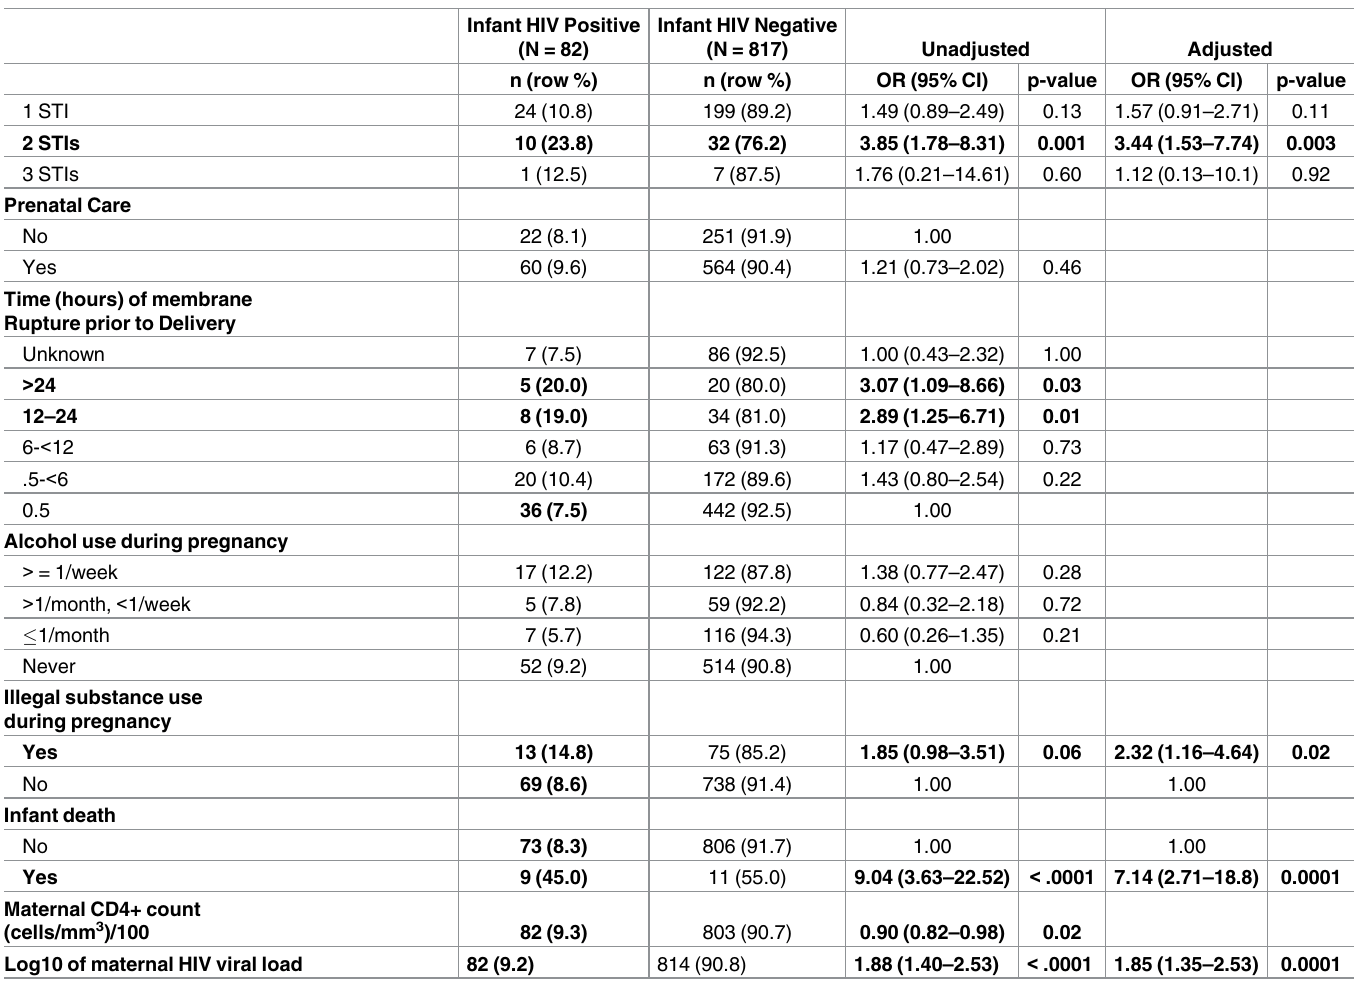
Abbreviations: 3TC = lamivudine; CI, confidence interval; CMV, cytomegalovirus; cCMV = congenital CMV infection CS = Cesarean section; CT = Chlamydia trachomatis ; HIV, human immunodeficiency virus; NFV = nelfinavir; NG = Neisseria gonorrhoeae ; NVP = nevirapine; OR, odds ratio; SD, standard deviation; STI = sexually transmitted infection; ZDV =